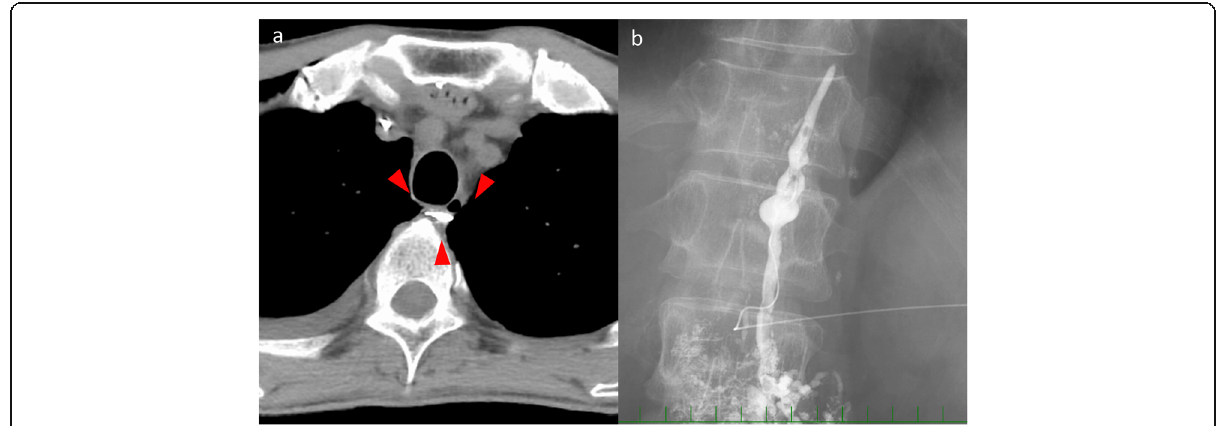
Fig. 3 a CT image taken after lymphangiography. Contrast agent leaked from thoracic duct at the level of bifurcation of trachea. b Lymphangiography through the cisterna chyli revealed thoracic duct was dissected in the thoracic cavity